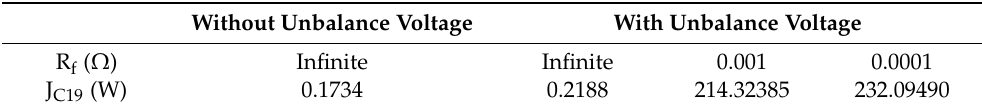
Table 5. Joule losses in the inter-turn short-circuited